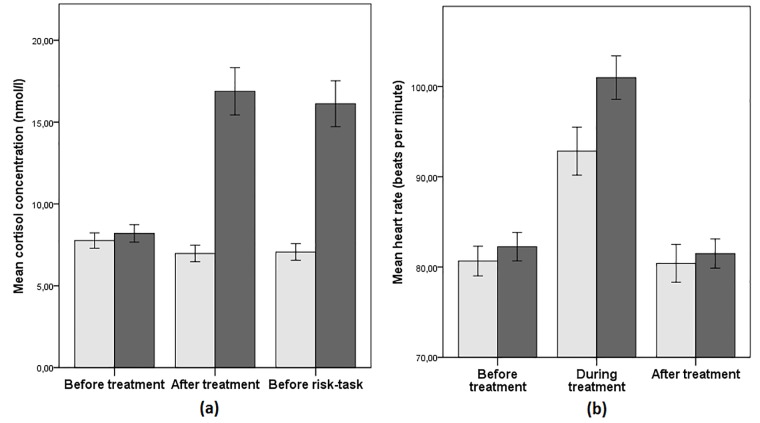
Induced stress reaction: Cortisol and heart-rate.Notes: The darker color indicates the treatment group. Panel (a): Mean levels of free salivary cortisol; Sample 1 was collected before the treatment or control TSST-G procedure, sample 2 after the TSST-G procedure and sample 3 before the risk task. Panel (b): Mean levels of heart-rate calculated from individual averages over the time periods before, during and after the TSST-G procedure. Error bars indicate standard errors of the mean.